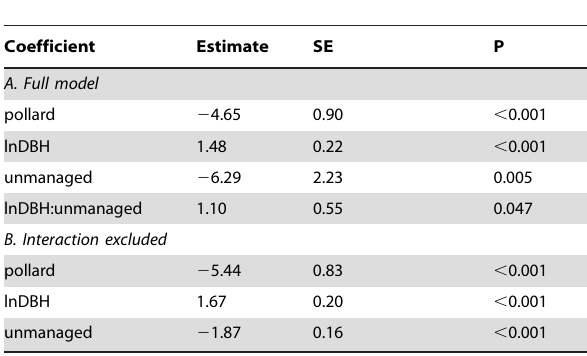
Table 2. Results of hollow presence analysis.